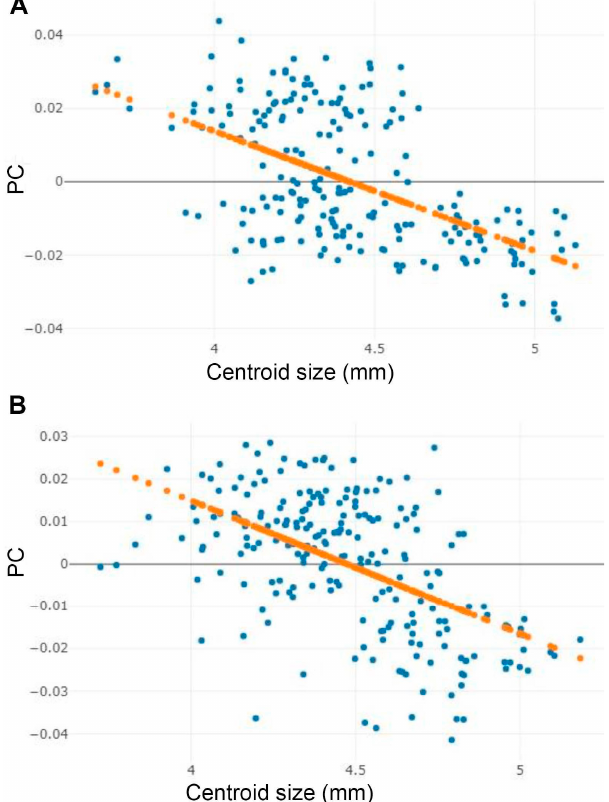
Figure 10. Linear regression between centroid size and first principal component (PC) of shape for the male ( A ) and female ( B ) Stomoxys species. Orange dotted line indicates linear regression prediction.